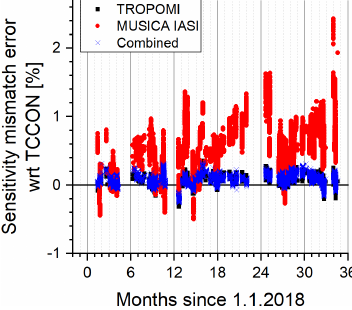
Figure F2. Error in the comparison of TCCON and satellite prod- ucts due to the a priori model error and the different column sen- sitivities of the TCCON product and the satellite products. These T )( x − x values are calculated as ( a ∗ T − a ∗ TM5 CAMS ) and are TC Figure F3. Theoretically predicted and observed 1 σ scatter for the represented in Eq. (F1) by the square root value of the term ( a ∗ T − T ) S T ) T . ∗ T − a ∗ comparison of single pixel satellite data with individual TCCON a ∗ (cid:49) a ( a TC TC and AirCore reference data. Black, red, and blue colours represent TROPOMI, MUSICA IASI, and combined satellite data, respec- tively. The squares and vertical crosses are for XCH 4 comparisons with TCCON and AirCore references, respectively. The diagonal crosses and stars are for tropospheric and UTLS partial-column comparisons, respectively, with AirCore